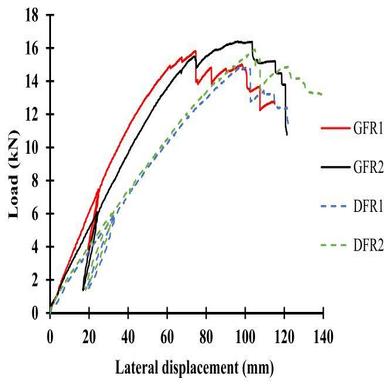
Load-lateral displacement graph.